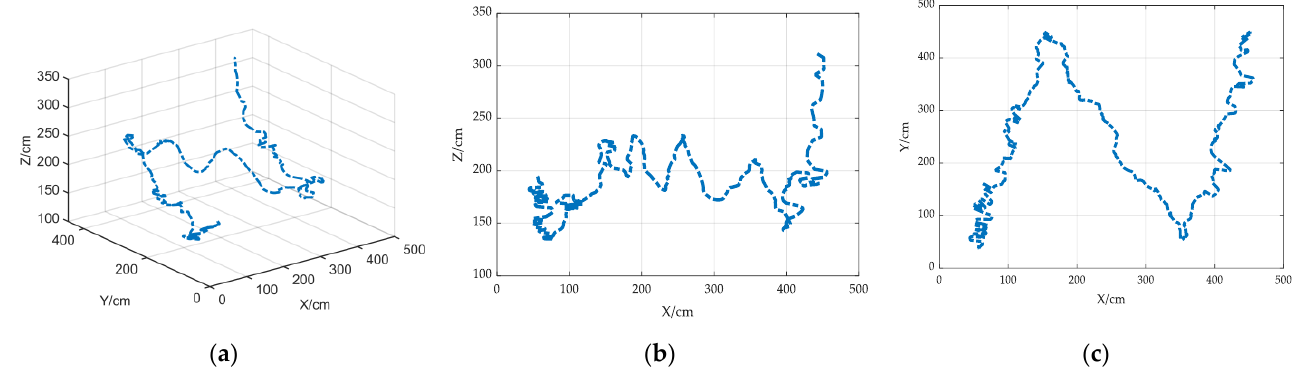
Figure 16. Trajectory of the target: ( a ) View of three-dimensional; ( b ) View of XOZ; ( c ) View of XOY.